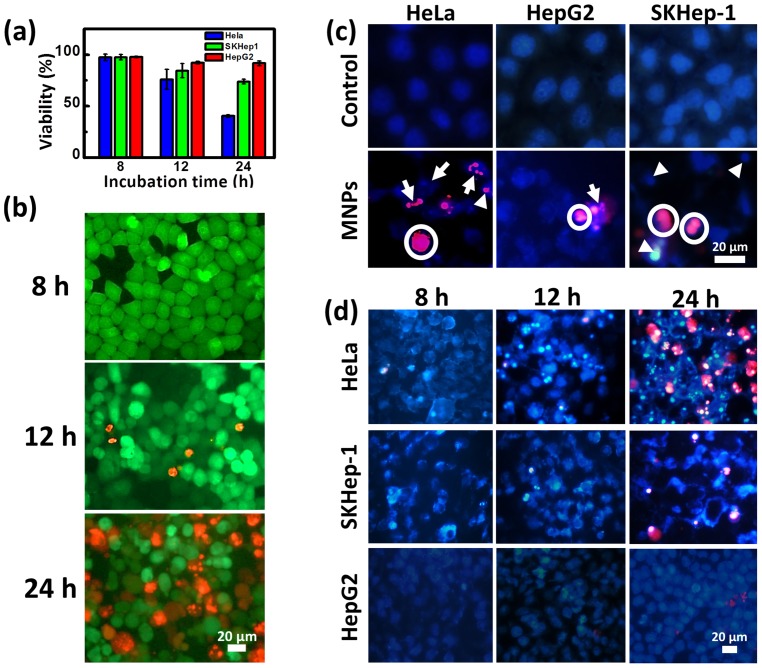
Cytotoxicity effects of single cell and bulk cell populations.(a) Cytotoxicity effects were analyzed by MTT. The data represents as the mean ±SD, and acquired from 3 independent tests. (b) The cytotoxicity effects of HeLa cells are shown by the overlay fluorescence images of GFP and PI as the MNP incubation time increased from 8 to 24 h. Green, live cells expressed green fluorescent protein (GFP); Red, dead cells stained by PI. The scale bar represents 40 µm. (c) Overlay fluorescence images of DAPI/PI stain distinguishing mechanisms of cell death (SKHep-1, HepG2 and HeLa) after treating with MNPs for 24 h. Control: cells were not treated with MNPs for 24 h in parallel to the treated groups. Apoptotic nuclei stained with DAPI showed intense blue fluorescence corresponding to chromatin condensation (indicated by arrow heads) and fragmentation (indicated by arrows). Defective cell membrane allowed PI to enter cytoplasm indicating that cells underwent late apoptosis or necrosis. Possible necrotic cell that correspond to those without clear nuclear fragment but stained with intense PI were circled. (d) Time course experiment of the DAPI/PI staining for the three kinds of cells.